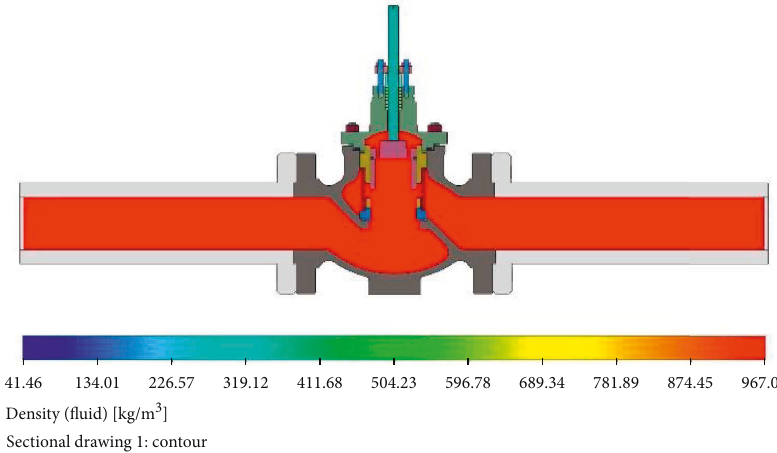
Figure 33: Fluid density cloud map for 80% opening.